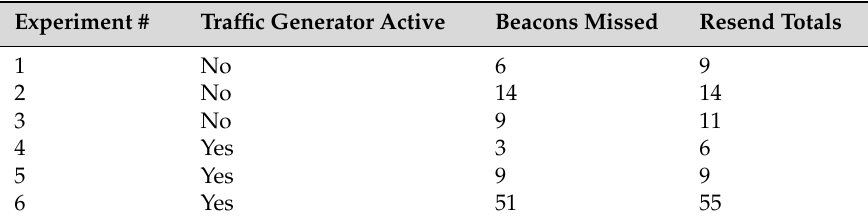
Table 5. Data from the tracking node